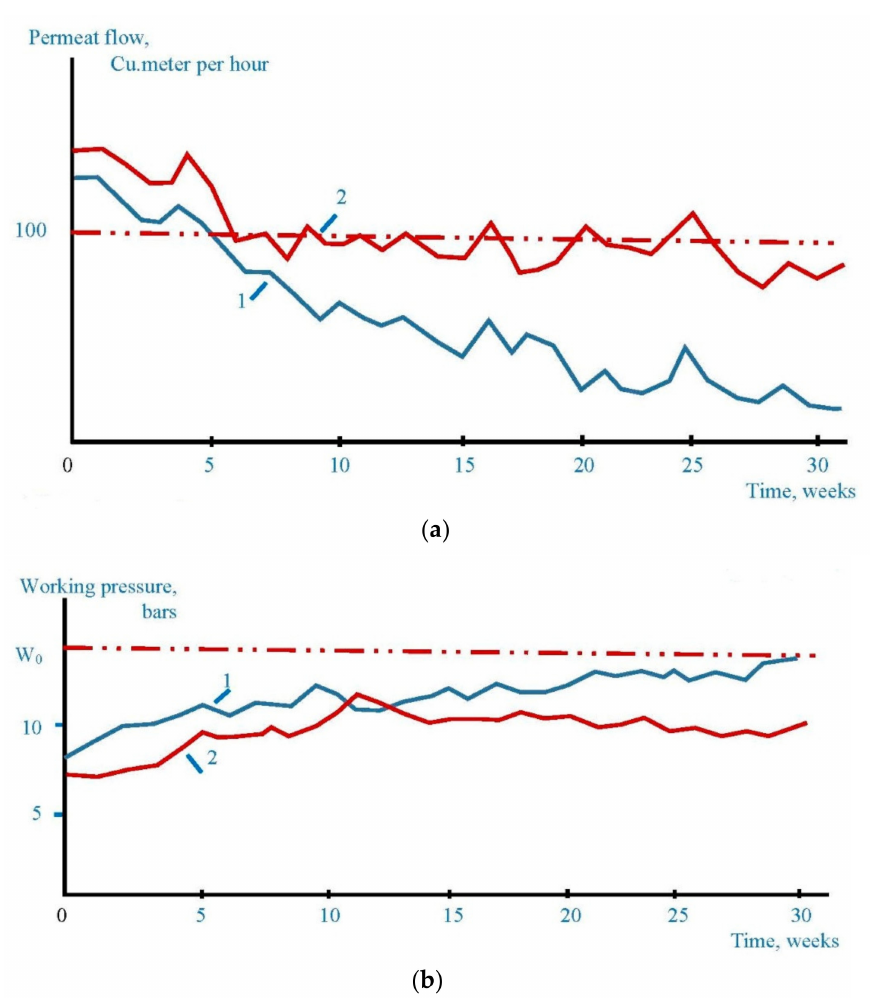
Figure 17. Comparison of the RO unit operation using different antiscalants. Reduction of membrane product flow with time ( a ) and working pressure increase ( b ) using Aminat-K and